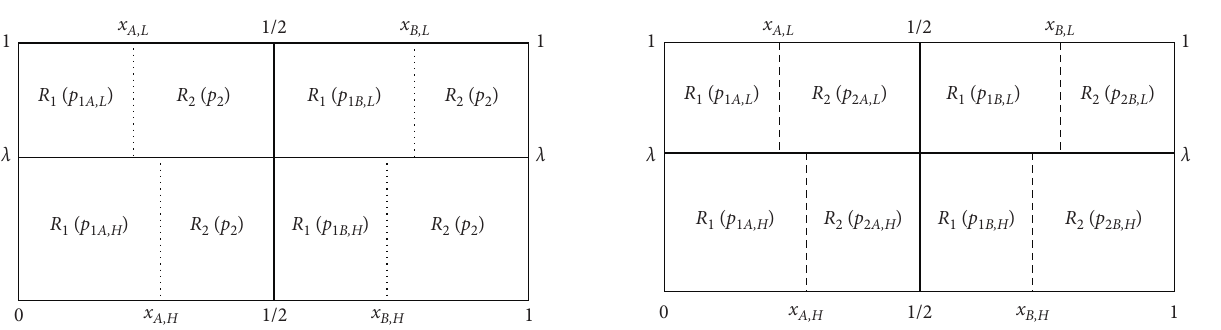
Figure 4: Consumers’ distribution and retailers’ market shares in the II model.